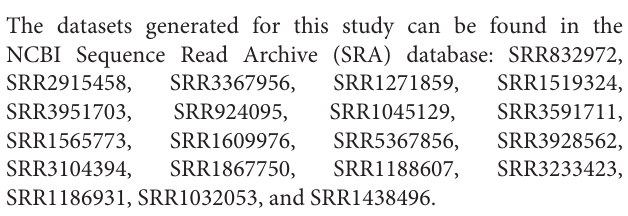
FIGURE S1 | FastQC results of each sample before and after quality control. (A1,B1,C1,D1) Results of raw data. (A2,B2,C2,D2) Results of clean data. (A1,A2) Average quality scores by nt locations of reads. (B1,B2) Number distributions of reads in average quality scores. (C1,C2) Percentages of base N content by nt locations of reads. (D1,D2) Percentage distributions of sequence GC content, green for “pass,” yellow for “warn,” red for “fail”. FIGURE S2 | The length distribution of unigenes. FIGURE S3 | Distribution of sample gene expression level. Gene expression levels were measure by log10(TPM). The different colors of the curves represented different species. (A) Density of RNA-seq gene expression level. (B) Cumulative frequency of RNA-seq gene expression level. TABLE S1 | Summary of Chinese herbal medicines. TABLE S2 | Classification and sampling sources of 20 plants and reference